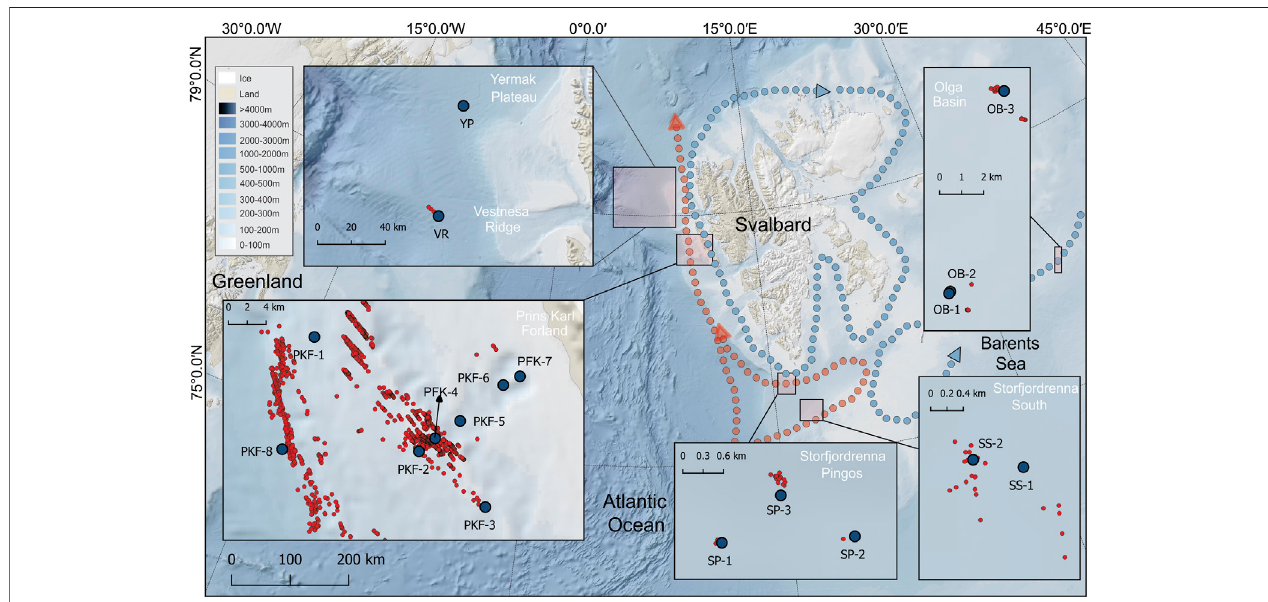
FIGURE 1 | Bathymetric map of sampling areas around Svalbard. Pale red and blue dotted lines show directions of the warm West Spitzbergen Current and cold polarcurrents,respectively.Fiveinsetsareshowntomagnifythesamplingareaswithindividualspatialscalesalongwithknownmethaneseepsindicatedbythereddots. Sampling stations within the insets are indicated by the blue dots and further information is provided in Table 1 .